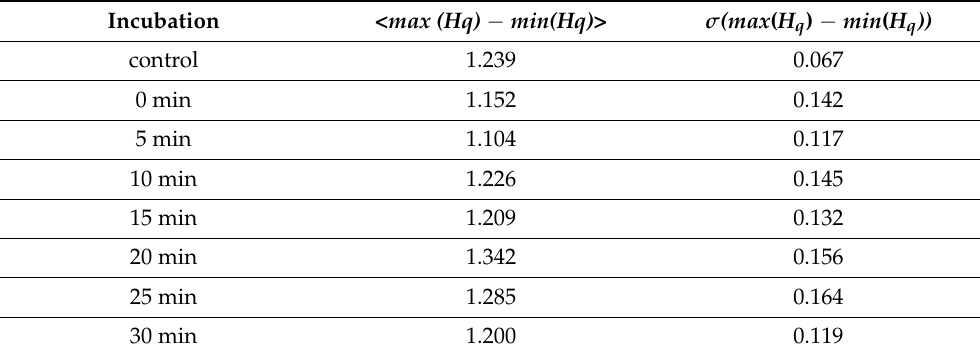
Table 3. The mean value and standard deviation of the singularity spectrum width with respect to the IAA incubation period. U = − 100